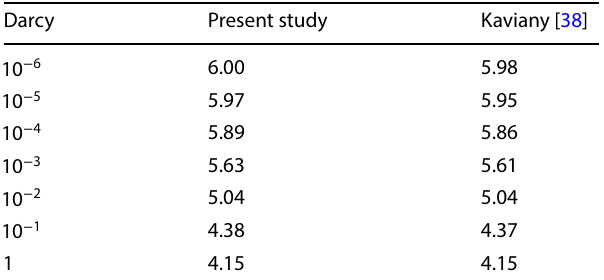
Table 2 The calculated Nu number vs analytical results of Kaviany